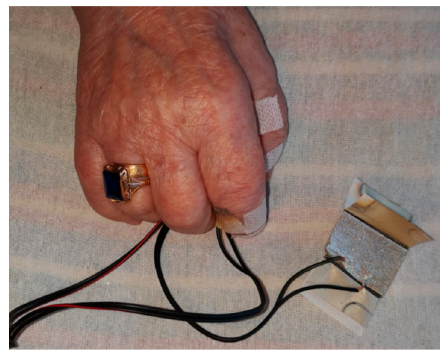
Figure 9. The alternative electrodes placed on the patient’s hand.